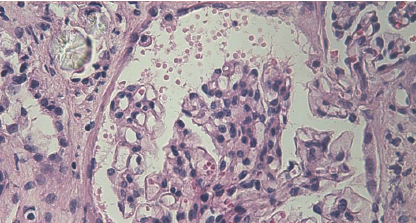
Figure 3: Light microscopy (H&E × 400) demonstrates oxalate crys- tal near